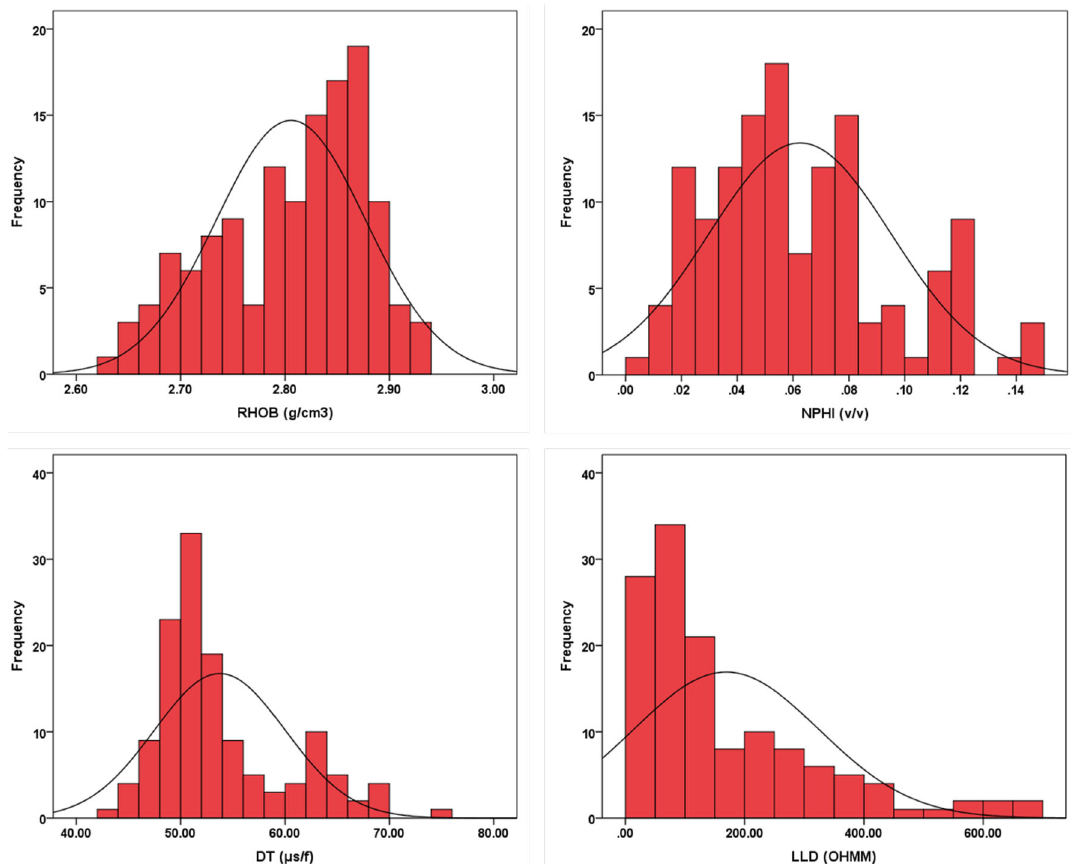
Fig. 6 Histograms showing the fitted Gaussian membership function to the RHOB, NPHI, DT, and LLD well logs